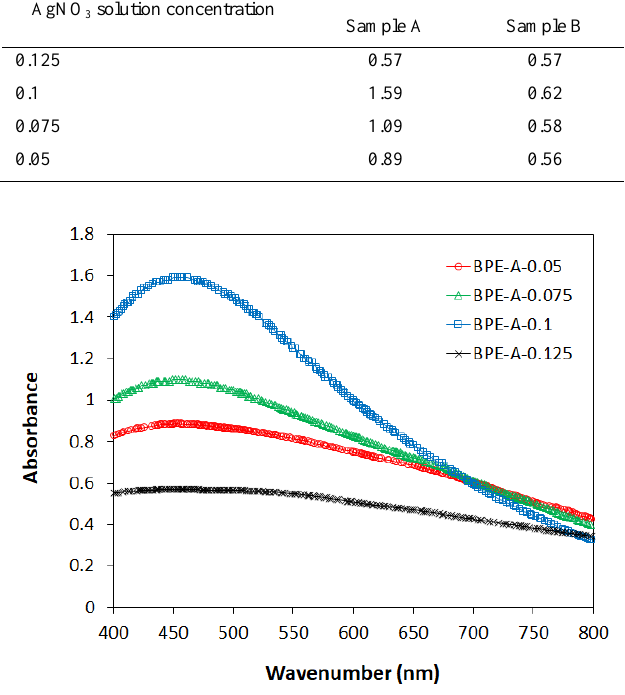
Fig. 8. Comparison of UV-Vis analysis results for samples A at various concentration of AgNO 3 solution (i.e. 0.05 M; 0.075 M; 0.1 M; 0,125 M)